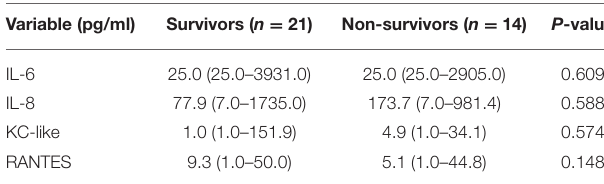
TABLE 6 | Comparison of plasma concentration of selected cytokines and chemokines (IL-6, IL-8, KC-like, and RANTES) in septic cats classified as survivors and